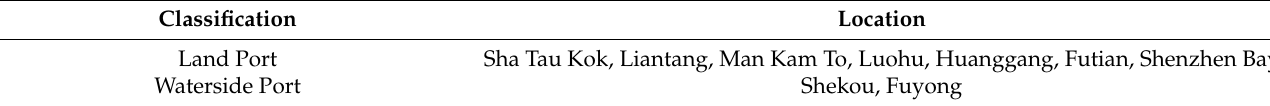
Table 1. Classification and geographical location of customs clearance ports.